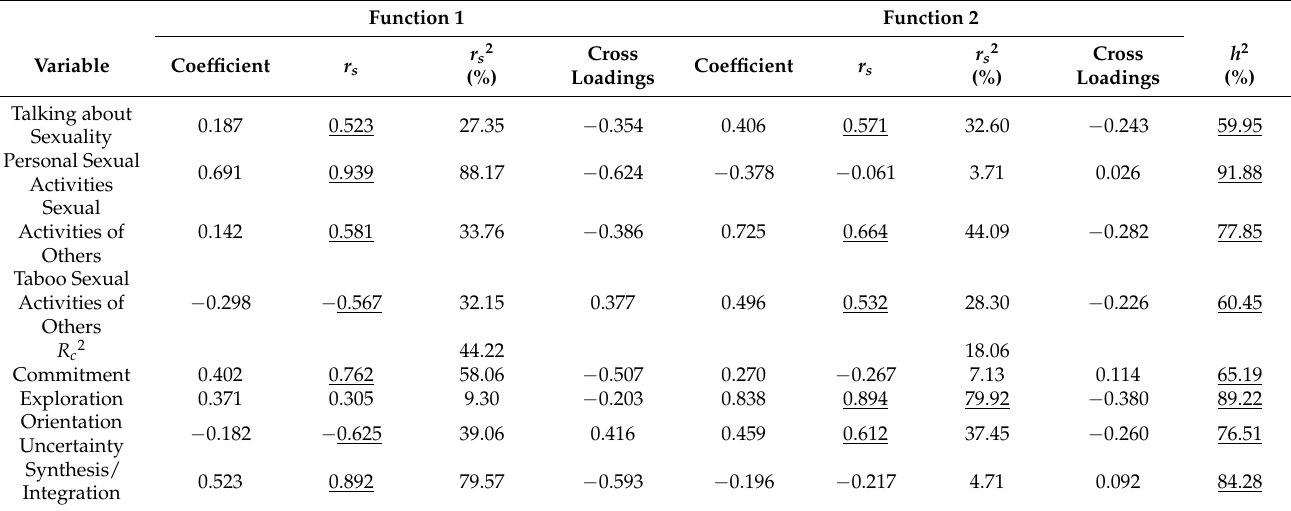
Table 3. Canonical solution for sexual identity development predicting comfort with sexuality for functions 1 and 2 ( n =